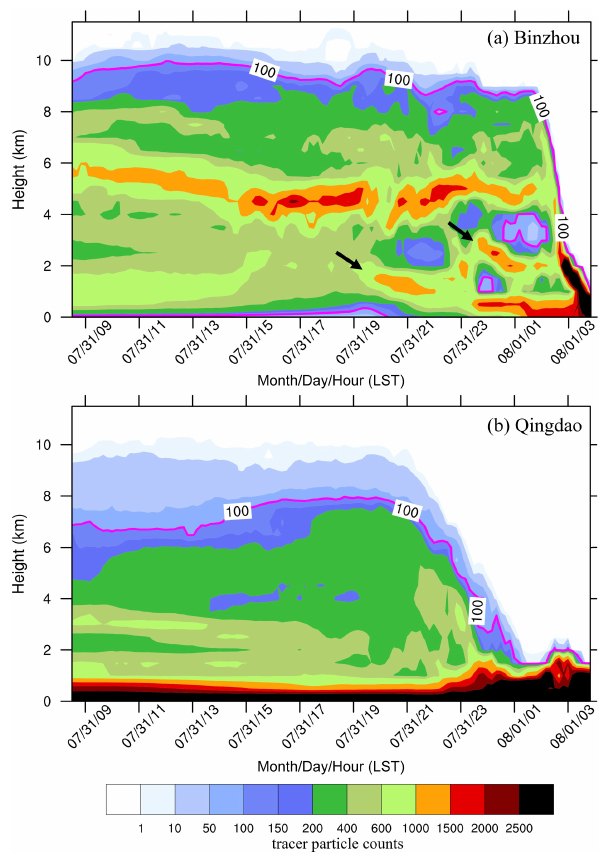
Figure 10. Temporal variations in vertical tracer particle counts re- leased at (a) Binzhou and (b) Qingdao. Tracer particle counts with a value of 100 (equalling 1% of the total number of released trac- ers) are highlighted by magenta lines. The black arrows highlight the two rapidly descending phases of stratospheric